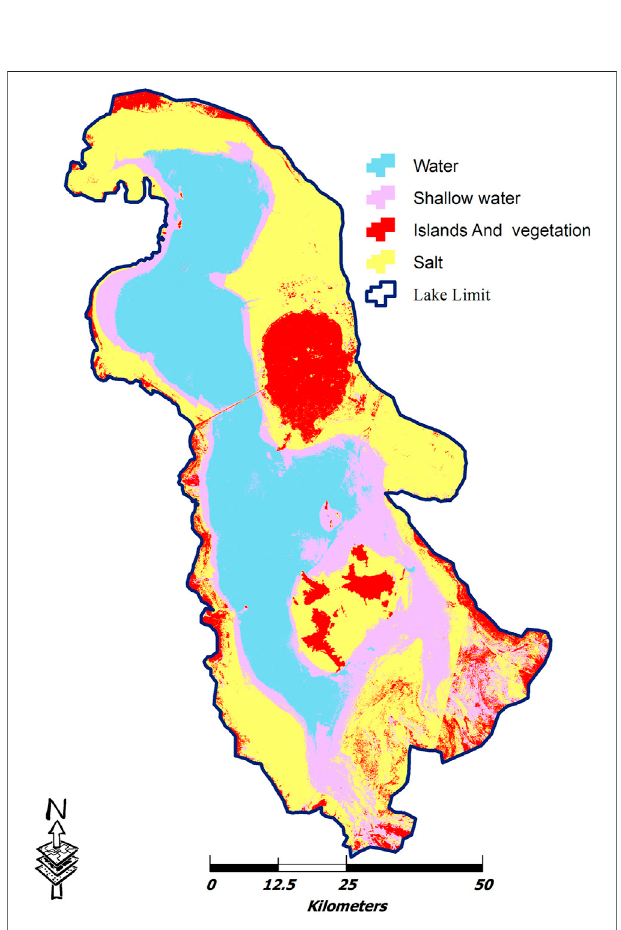
FIGURE 9 | Land-use class in 2016 (author ’ s illustration).